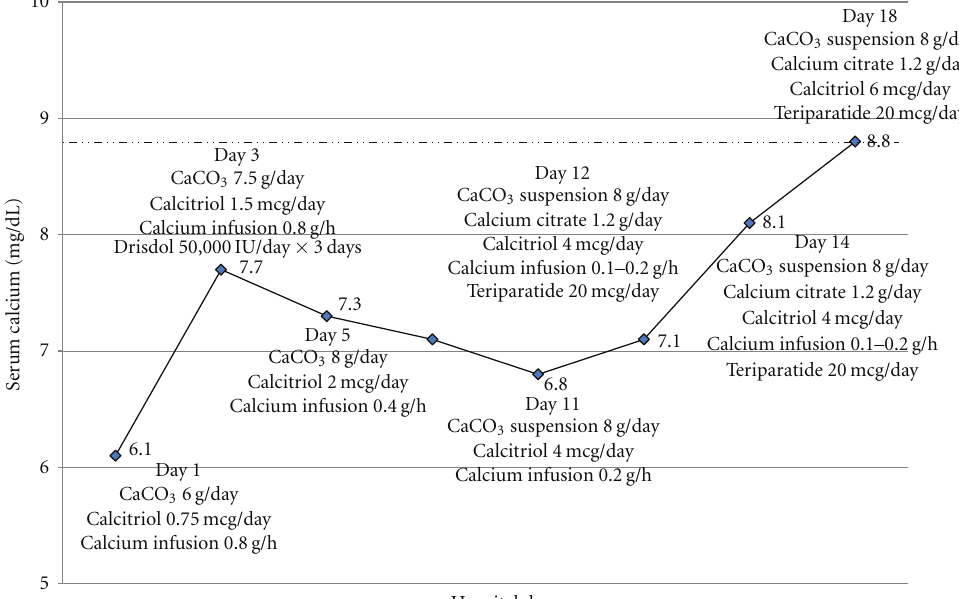
Figure 1: Calcium levels and treatment during the hospital